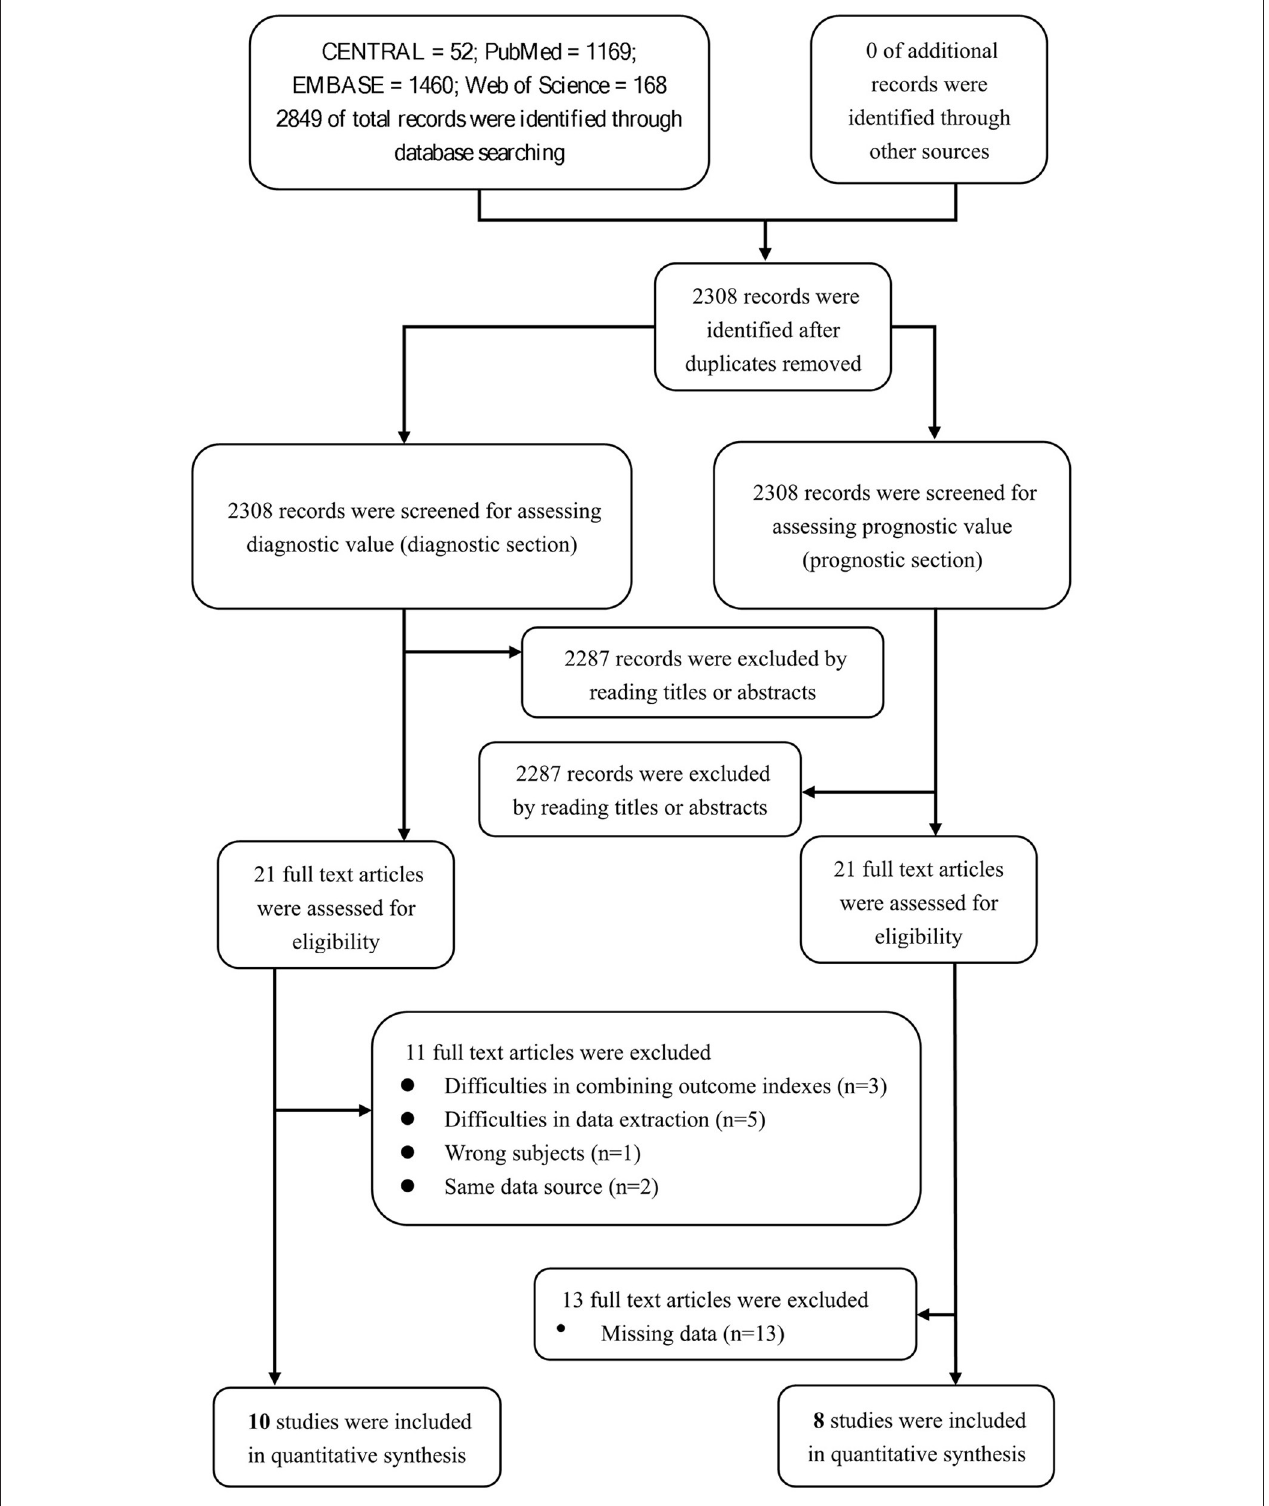
FIGURE 2 | Study flow